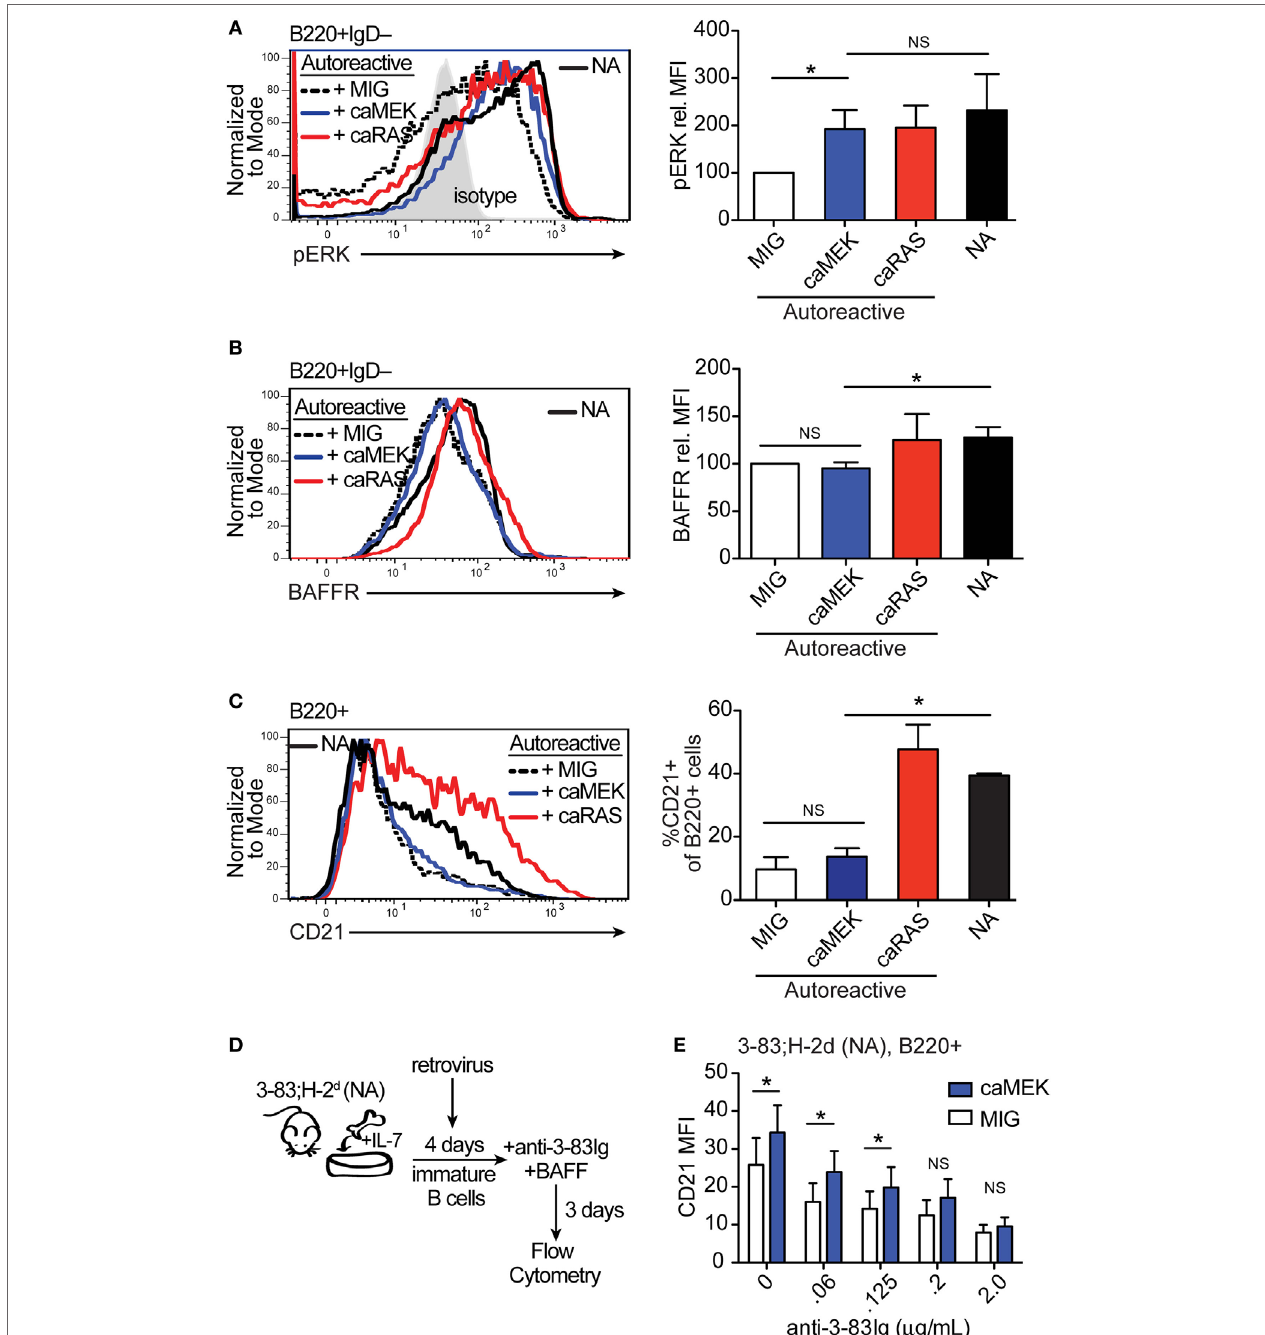
FigUre 3 | Extracellular signal-regulated kinase (ERK) activation drives the differentiation of low-avidity, but not high-avidity autoreactive B cells in vitro. (a,B) Representative histograms and bar graph quantification of phospho-ERK (pERK) (a) and BAFFR (B) in bone marrow immature B cells (B220 + IgD – ) cultured for 4 days with IL-7. The B cells analyzed were either non-transduced nonautoreactive (NA) (3-83Igi,H-2 d ) cells (black solid line) or autoreactive (3-83Igi,H-2 b ) cells transduced with MIG control (black dashed line), caMEK (blue line), or caNRas (red line) retroviral vectors. Transduced cells were gated on GFP + for analyses. Staining of pERK (in A) was done on cells treated with pervanadate. The gray shaded histogram in (a) represents isotype control antibody. (c) Representative histograms and bar graph quantification of the frequency of CD21 + cells in the B220 + B cell population after 3 days of culture with BAFF. (D) Schematic of the system utilized to investigate the effect of caMEK on the in vitro differentiation of immature B cells cultured with increasing amounts of BCR stimulation. 3-83Igi,H-2 d bone marrow cells were cultured with IL-7 for 4 days and transduced with retrovirus carrying either caMEK or MIG on the second day of culture. Cells were then incubated with BAFF and increasing amounts of an agonistic anti-3-83Ig idiotypic mAb (S23), this latter added each day during a 3 days culture. (e) CD21 expression (MFI) on B cells treated as described in (D) : caMEK-GFP, blue bars and MIG, white bars. In all panels, N = 3 total, from three independent experiments. * P ≤ 0.05; NS, not significant.